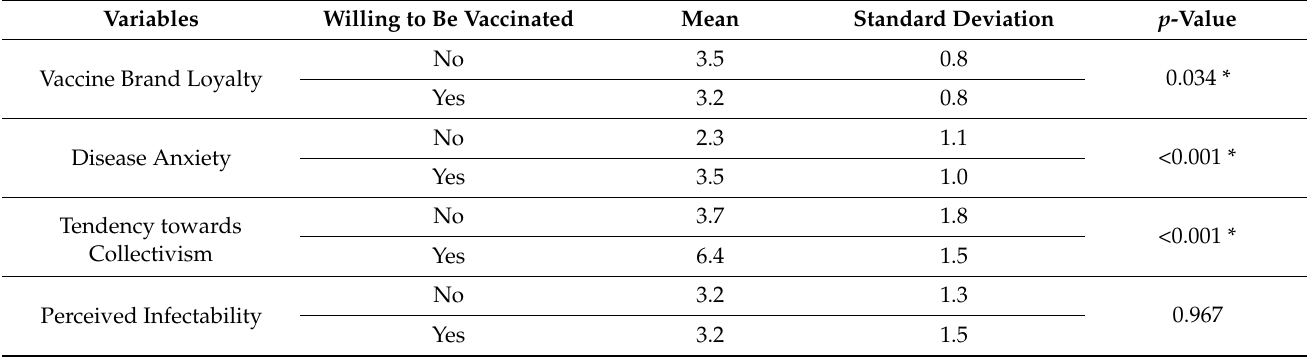
Table 2. The relationship between willingness to be vaccinated and various